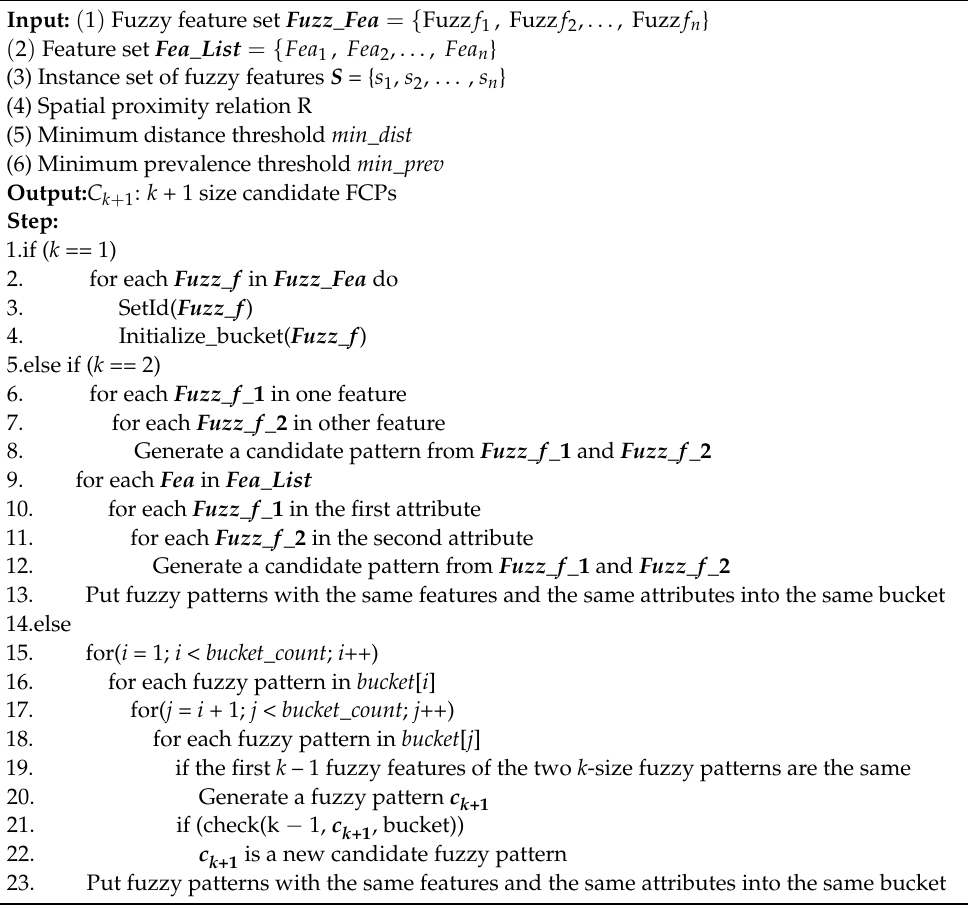
Algorithm 2: The algorithm for generating candidate FCPs based on